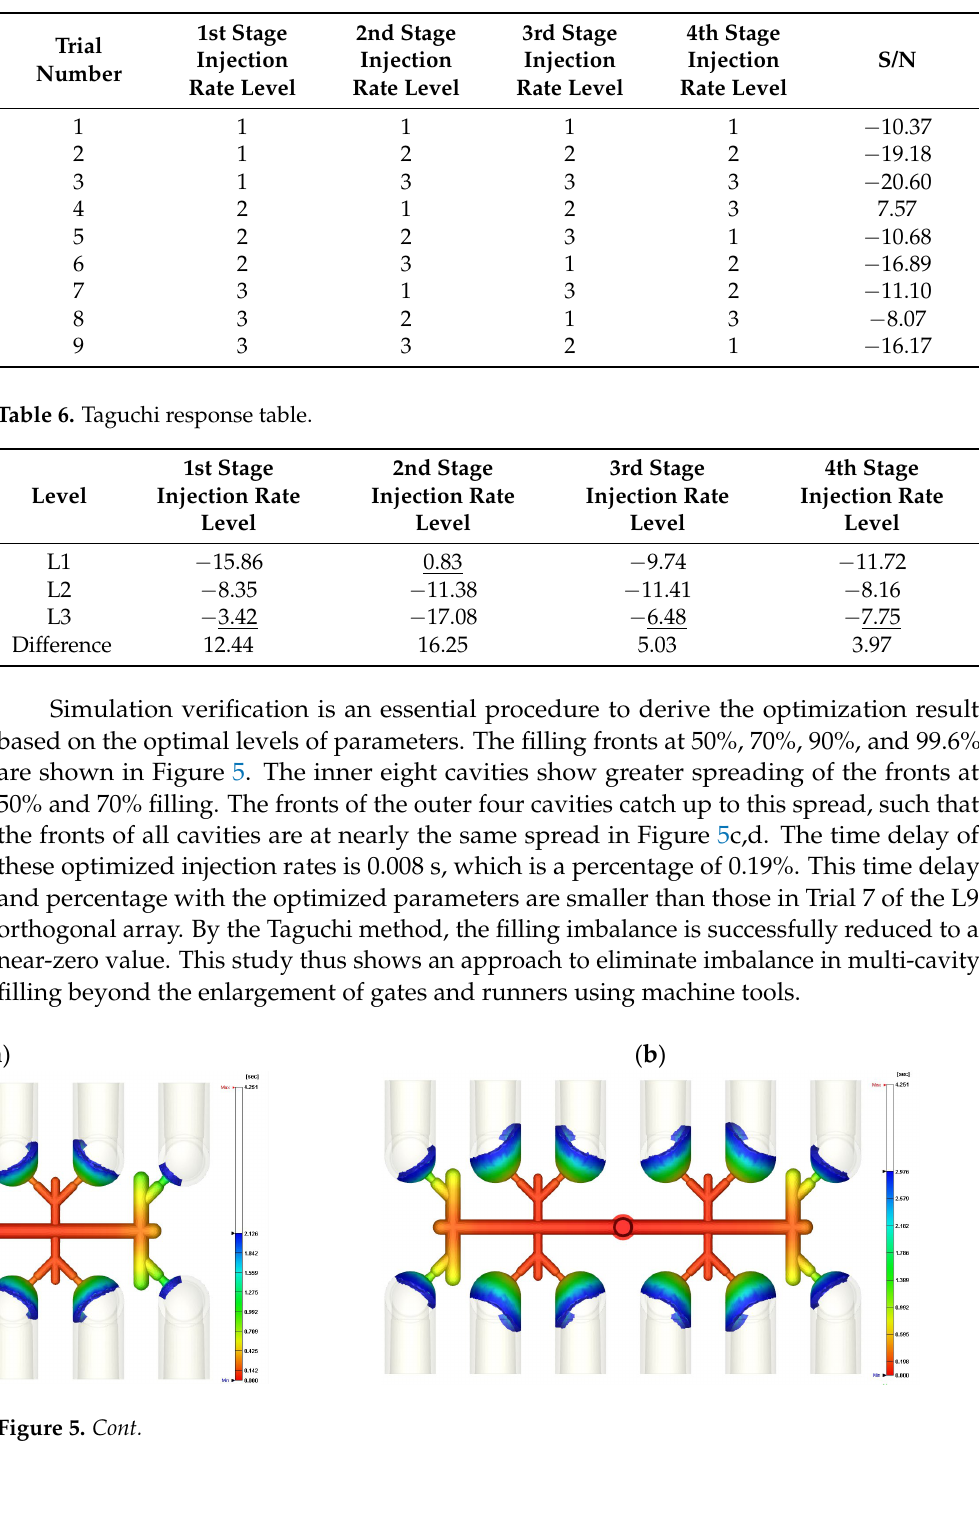
Table 5. Signal-to-noise ratios for “the smaller the better” quality characteristics.